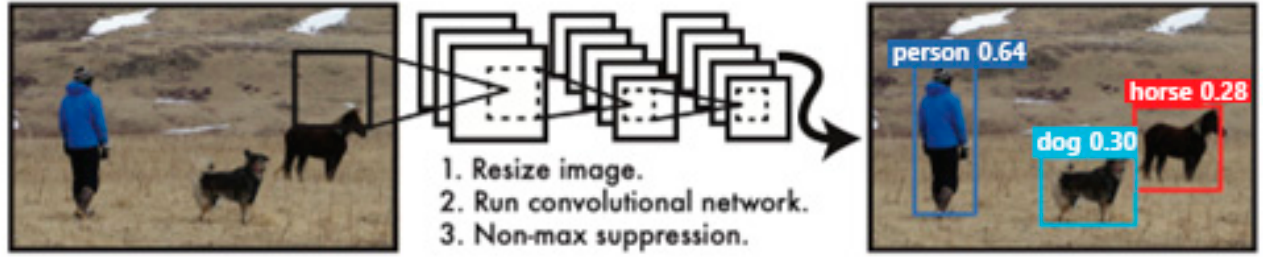
Figure 1. YOLO detection system [29].